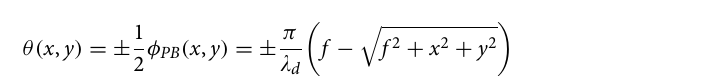
Figure 2. Polarization conversion efficiency (PCE) as a function of incident light wavelength and length ( a ), width ( b ), height ( c ) of the nanoblock. Horizontal dashed lines in ( a – c ) represent the optimized parameters ( L , W , H ) resulting in maximum PCE. ( d ) The simulated PCE of MgO nanoblock on a glass substrate as a function of wavelength. Vertical dashed lines represent the designated four different wavelengths (260 nm, 300 nm, 340 nm, 380 nm) that are chosen to characterize broadband metalens properties, with a minimum PCE of 74%. The optimized structural parameters of nanoblocks are L = 180 nm, W = 75 nm, H = 900 nm, and unit cell with period P = 200 nm. ( e ) Calculated phase profile of nanoblocks as a function of rotation angle θ within range of ◦ ◦ 0 –180 , at the designated